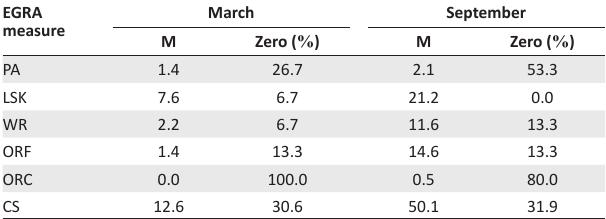
TABLE 4: Descriptive statistics for T1 classroom in school